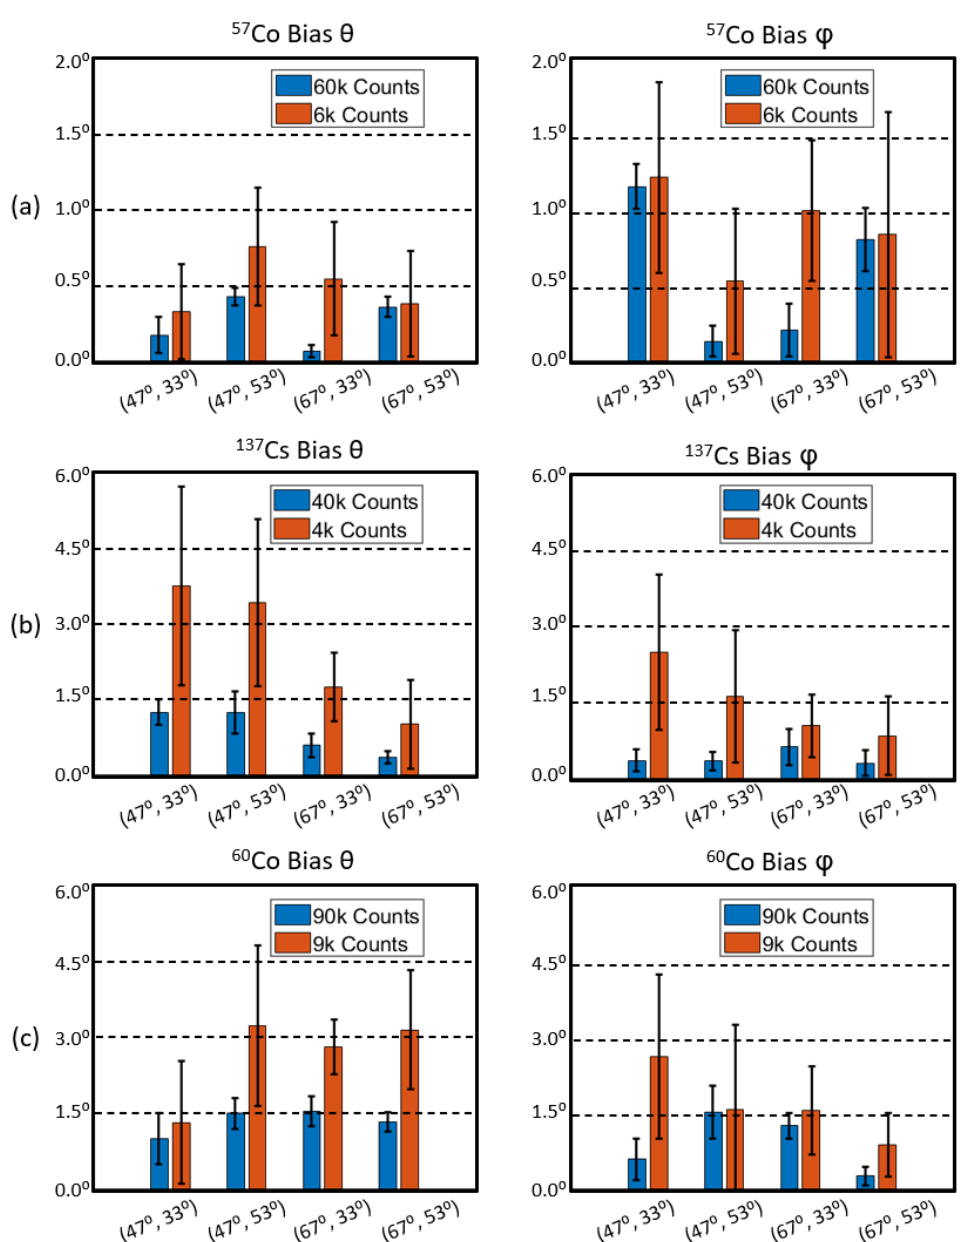
Figure 12. Positioning bias of θ and ϕ for locating ( a ) 57 Co, ( b ) 137 Cs, and ( c ) 60 Co point sources with different count levels.